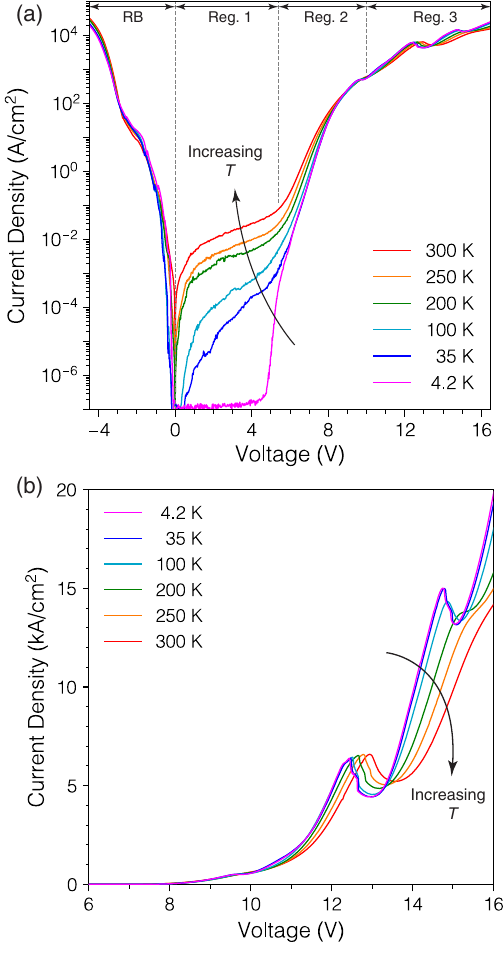
FIG. 3. (a) Semilogarithmic I - V plot showing regions with different transport regimes as a function of temperature: Under reverse bias (RB), the current exhibits a weak temperature dependence. In contrast, within region 1 a strong temperature dependence is measured since the current is enabled mainly by thermionic electrons. Region 2 presents a weak dependence on temperature due to the enhancement of the tunneling current component. Transport within region 3 is mainly due to resonant tunneling of carriers. (b) Forward I - V curves at different temper- atures showing the repeatable room-temperature resonant peak and a higher-order resonance for temperatures below 200